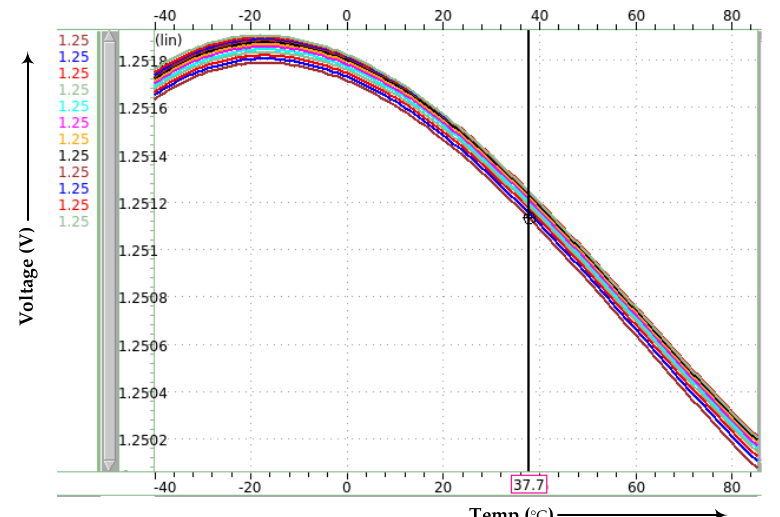
Figure 10. Variation in Vbg over a wide temperature range.